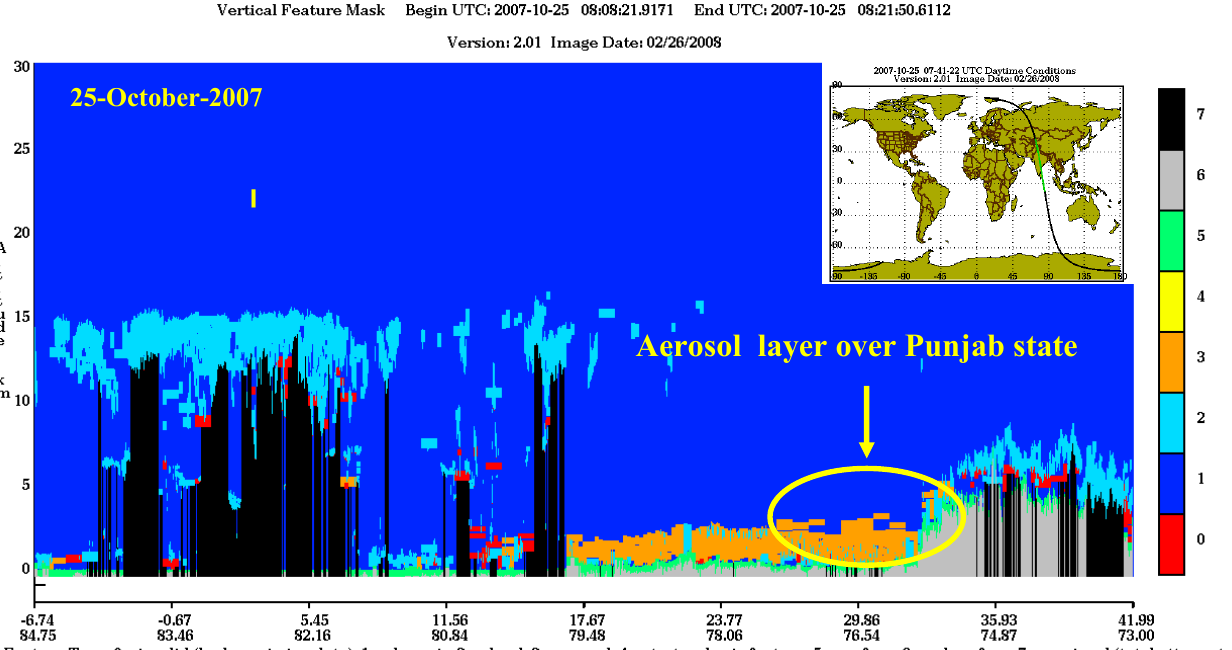
25-October-2007